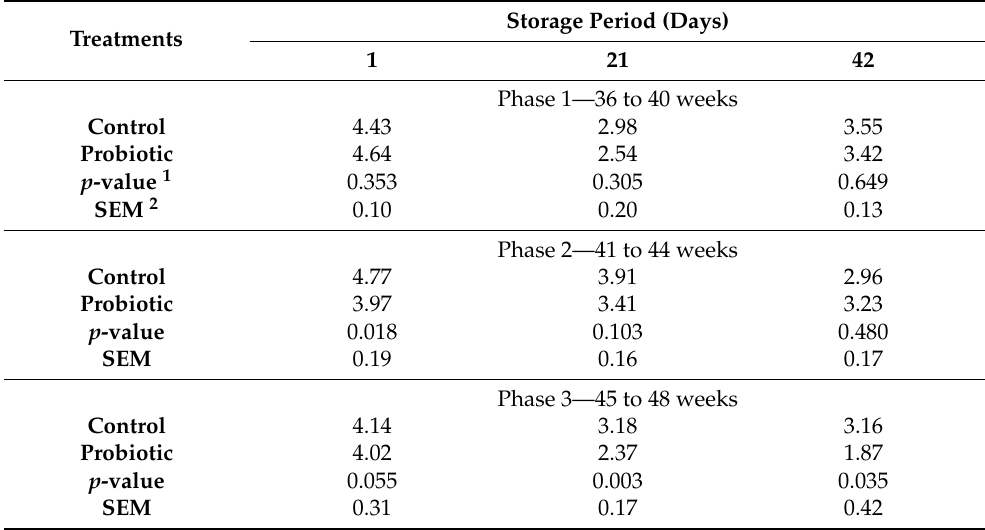
Table 9. Thiobarbituric acid reactive substances in eggs from laying hens fed β